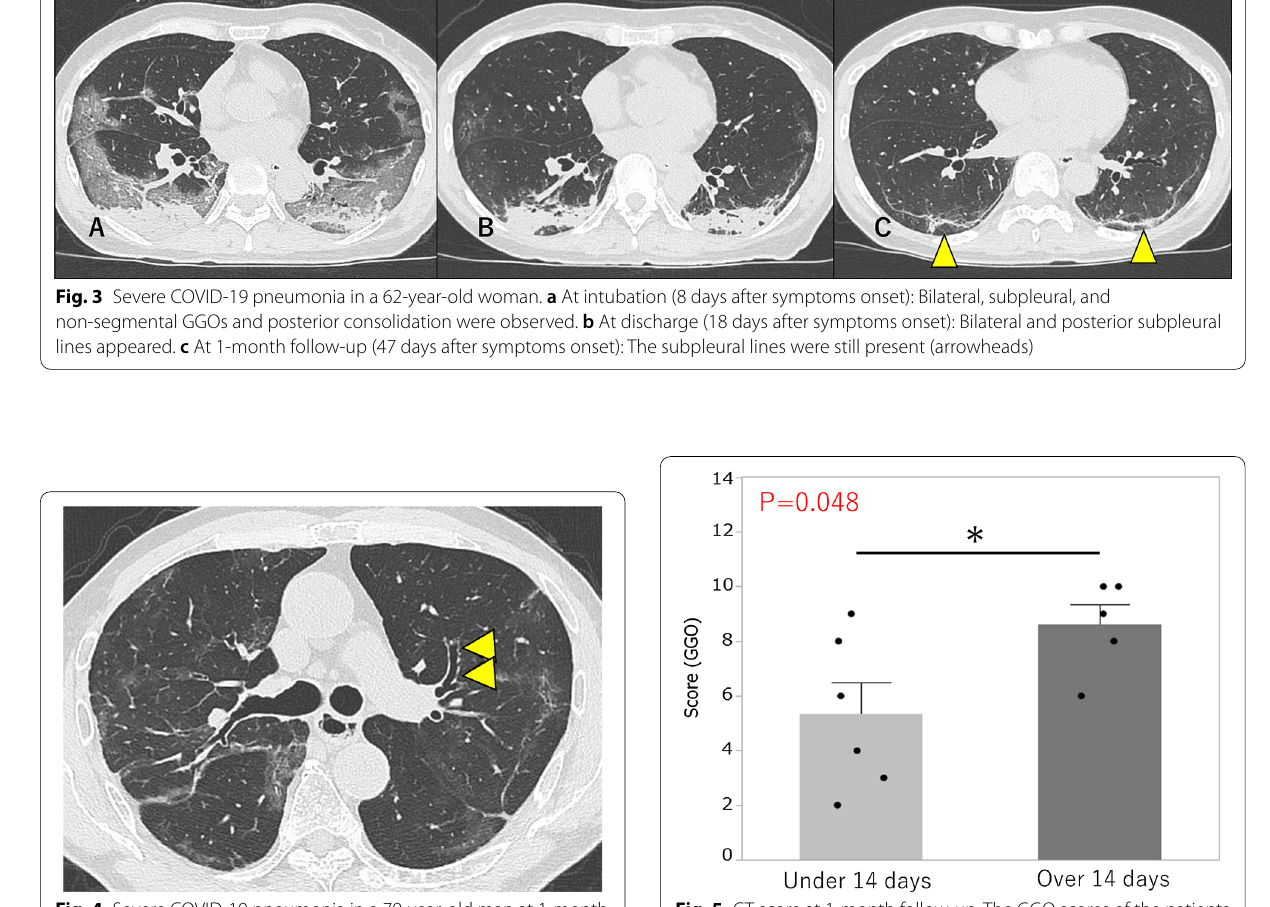
Fig. 4 Severe COVID-19 pneumonia in a 79-year-old man at 1-month follow-up after discharge (59 days after symptoms onset). Bronchus distortion and bronchial dilatation were observed (arrowheads). Multiple GGOs remained in both lungs